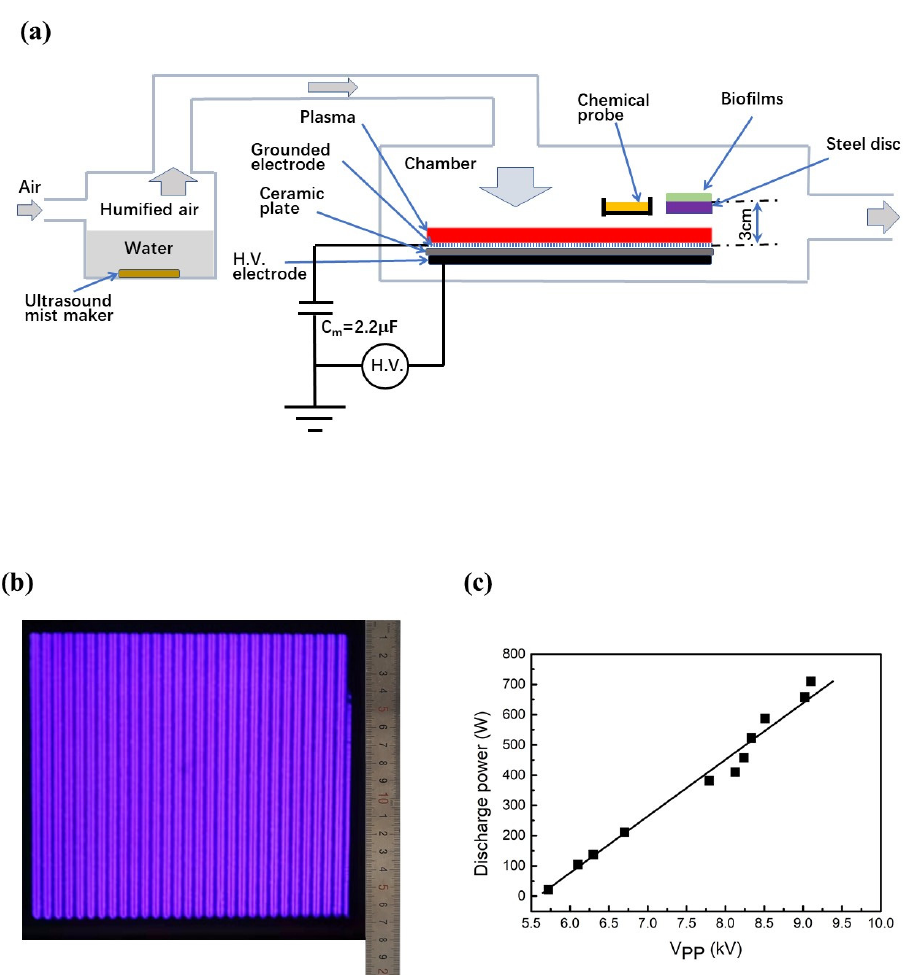
Figure 1. Humidified air surface dielectric barrier discharge (DBD) system for the inactivation of Escherichia coli ( E. coli ), Staphylococcus aureus ( S. aureus ), and bacteriophages in biofilm. ( a ) Schematic of the humidified air surface DBD plasma system. The plasma inactivation system consists of a tank filled with distilled water, a discharge chamber, surface DBD device, and a power supply. The surface DBD device consists of a layer of aluminum tape (0.13 mm thick) serving as an H.V. electrode, an insulating alumina plate (1.0 mm × 175 mm × 175 mm), and a patterned ground electrode (30 µ m thick) covered by a layer of Kapton polyimide tape. An AC power source was capable of generating the 1.0–10.0 kV peak-to-peak voltage (V PP ) with a frequency of 10 kHz. One capacitor of 2.2 µ F in series to ground was used to obtain a Lissajous figure of this charge. The air was humidified when passing over the water surface, and the humidity level was 60–70% at a room temperature of 20 °C. The steel discs with dry biofilms were placed into the humidified air DBD chamber for plasma inactivation. Chemical probes were used to capture the RONS in the gas phase; ( b ) The photo of the surface DBD plasma obtained at V PP = 8.25 kV. The surface DBD plasma was generated over the alumina plate with its surface area of 155 mm × 155 mm; ( c ) The discharge power as a function of V PP . Measurements for the charges across this capacitor and the applied voltage across the DBD device resulted in the Lissajous figure, which was used to calculate the discharge